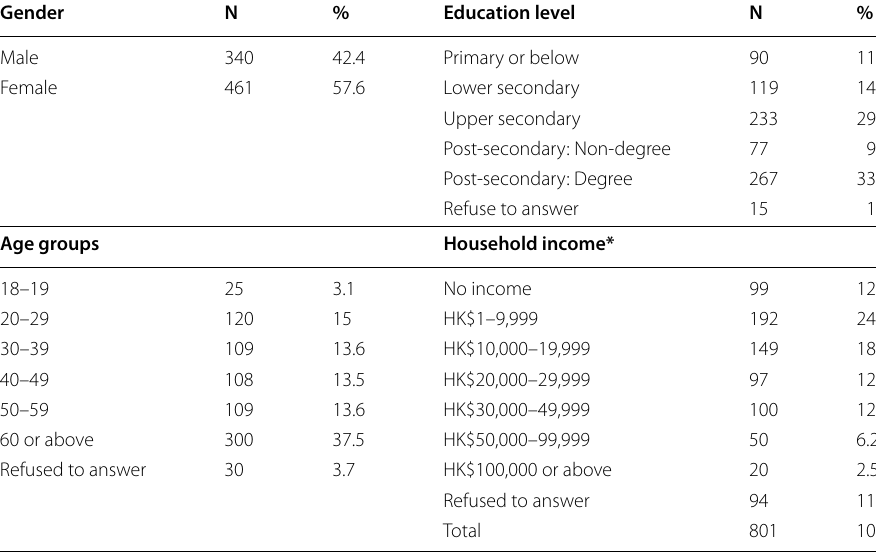
Table 1 Demographic characteristics of